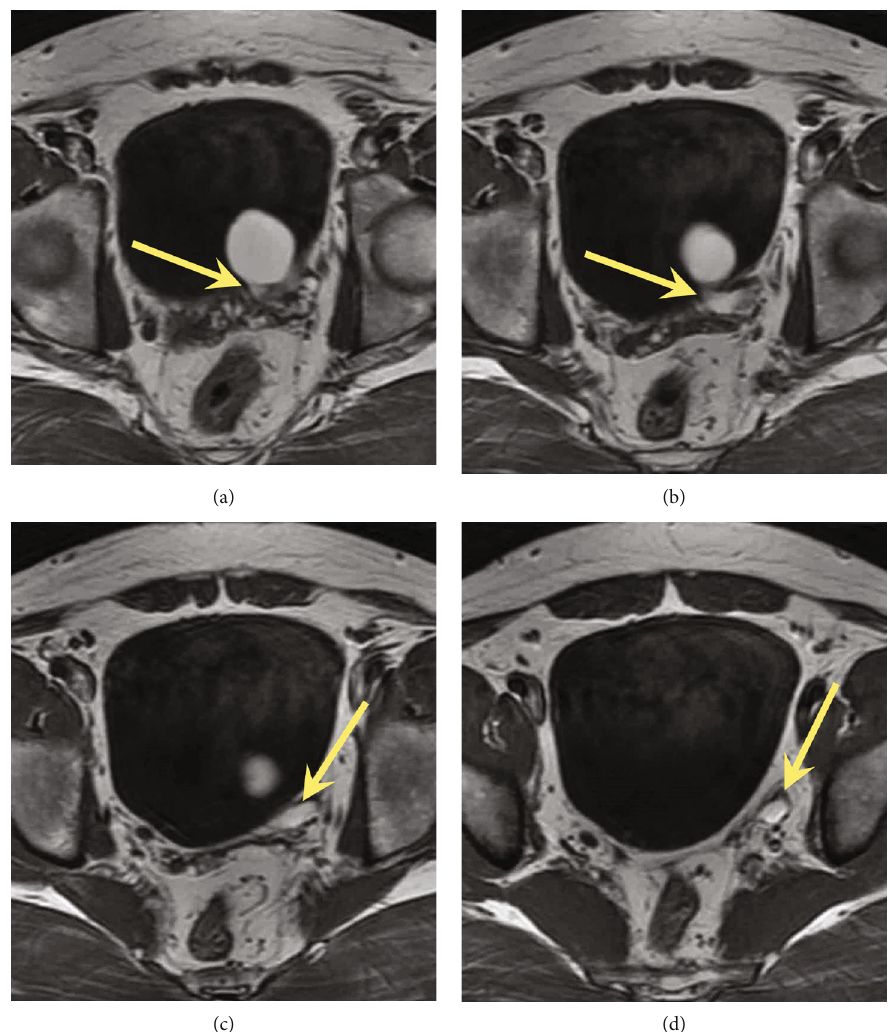
Figure 4: MRI axial superposed images on the seminal vesicle cyst in the T1-weighted sequence. Yellow arrow showing the tubular structure linked to the seminal vesicle cyst considered an ectopic